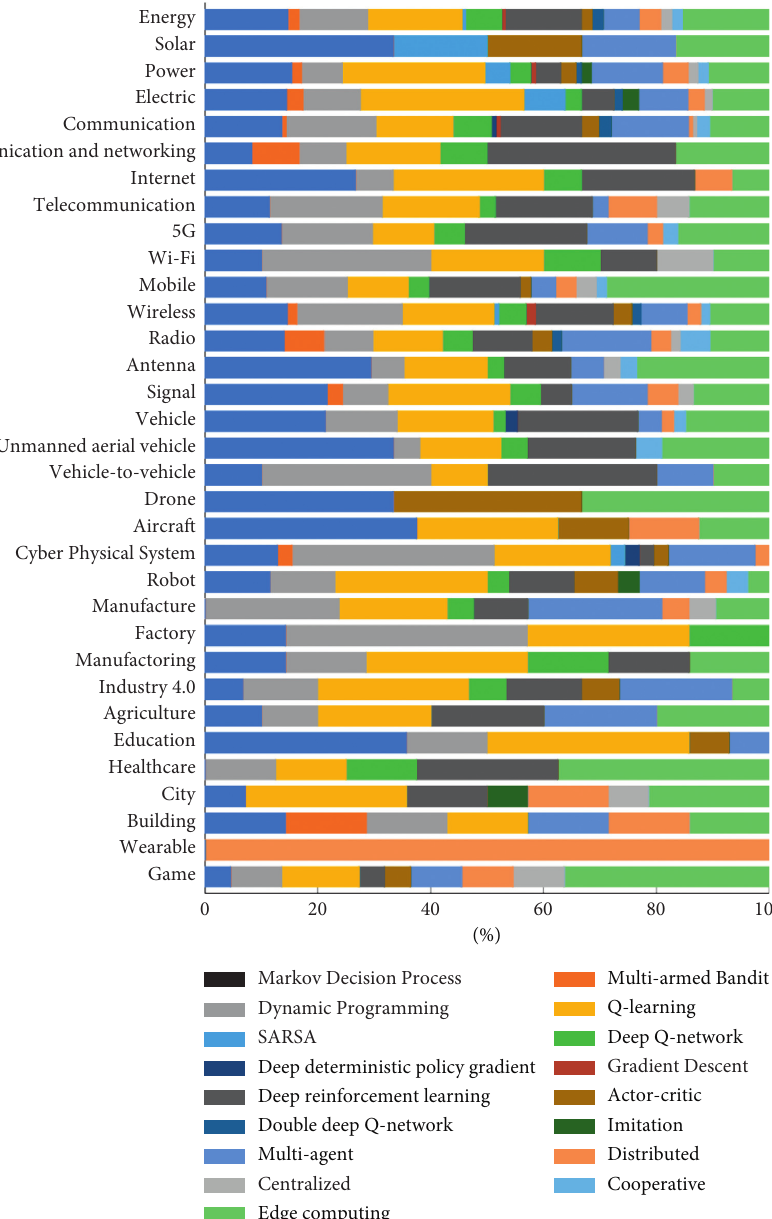
Figure 5: Distribution of RL methods by industrial field